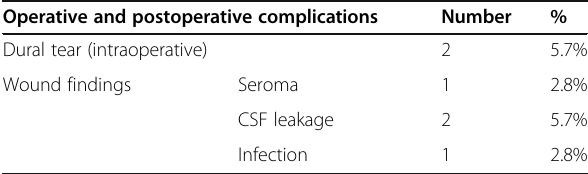
Table 6 Operative and postoperative